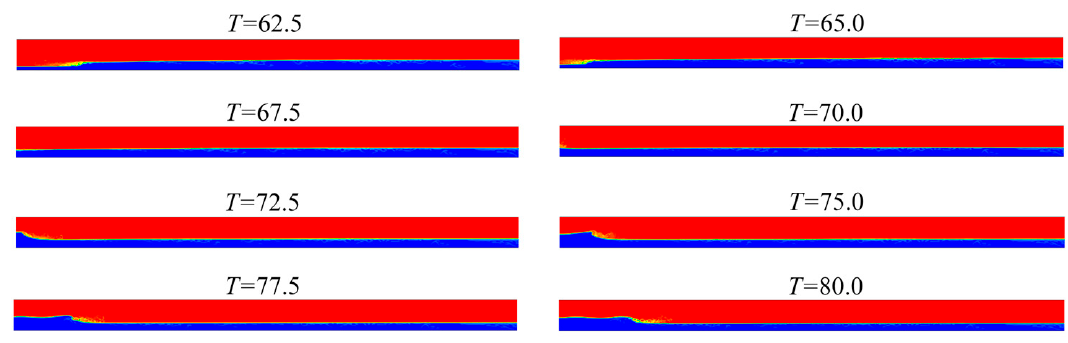
Figure 17. Free surface at T = 62.5–80.0.